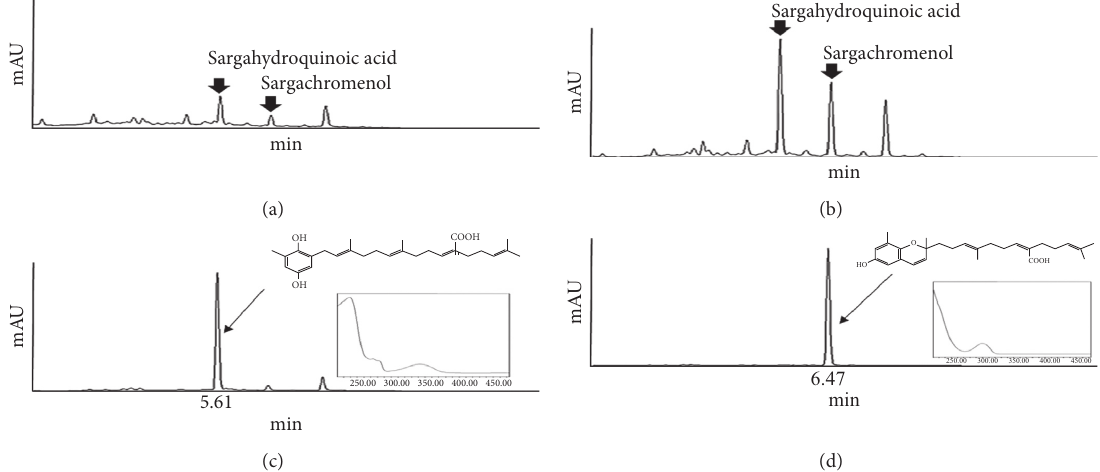
Figure 1: UPLC Chromatograms of (a) S. serratifolium , (b) S. miyabei Yendo, (c) sargahydroquinoic acid, and (d) sargachromenol